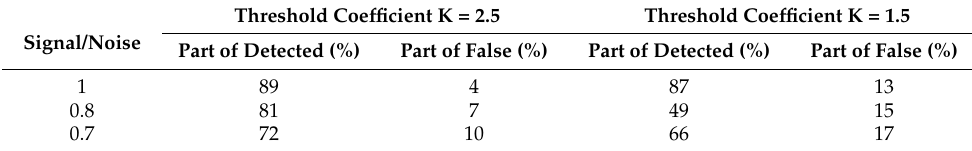
Table 2. Table 2. Risks.